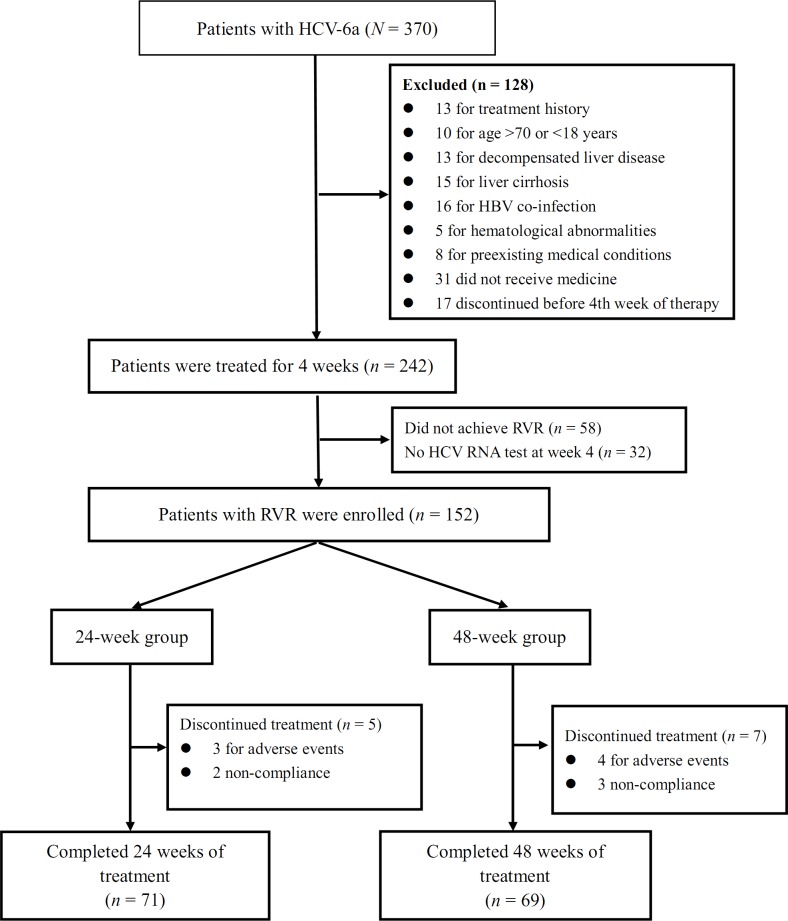
CONSORT flow diagram.Abbreviations: HBV, hepatitis B virus; HCV, hepatitis C virus; RVR, rapid virological response.